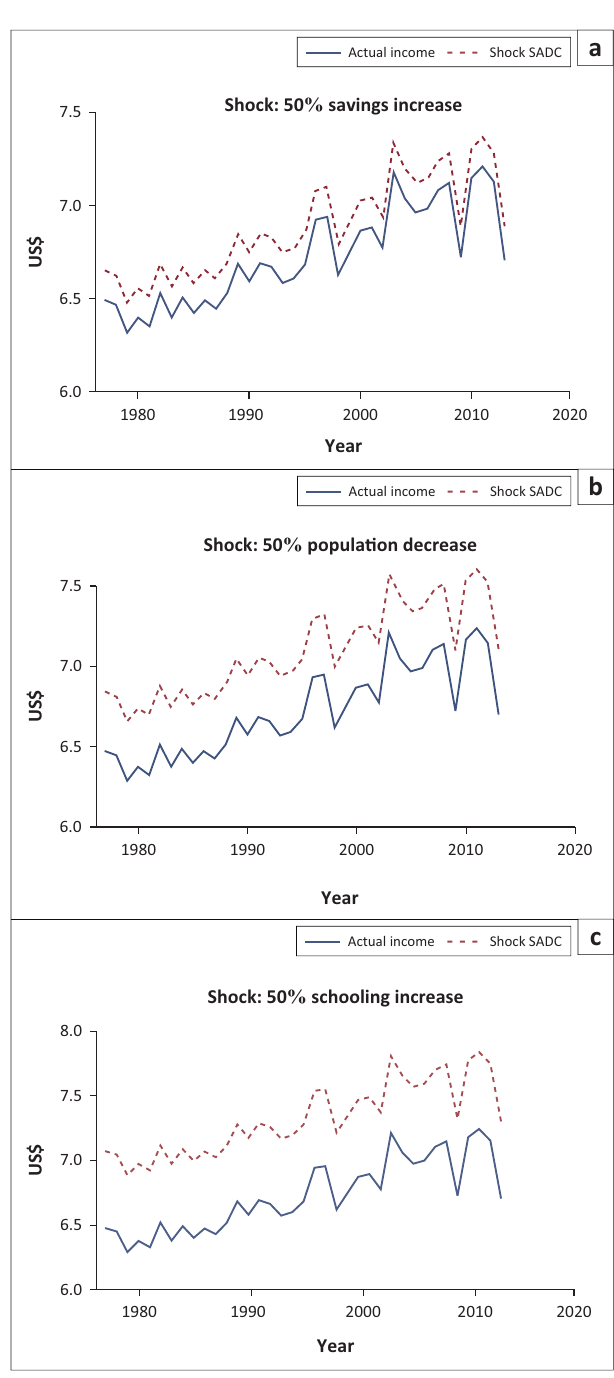
FIGURE 5: Graphs summarising shocks in (a) savings, (b) population and (c)